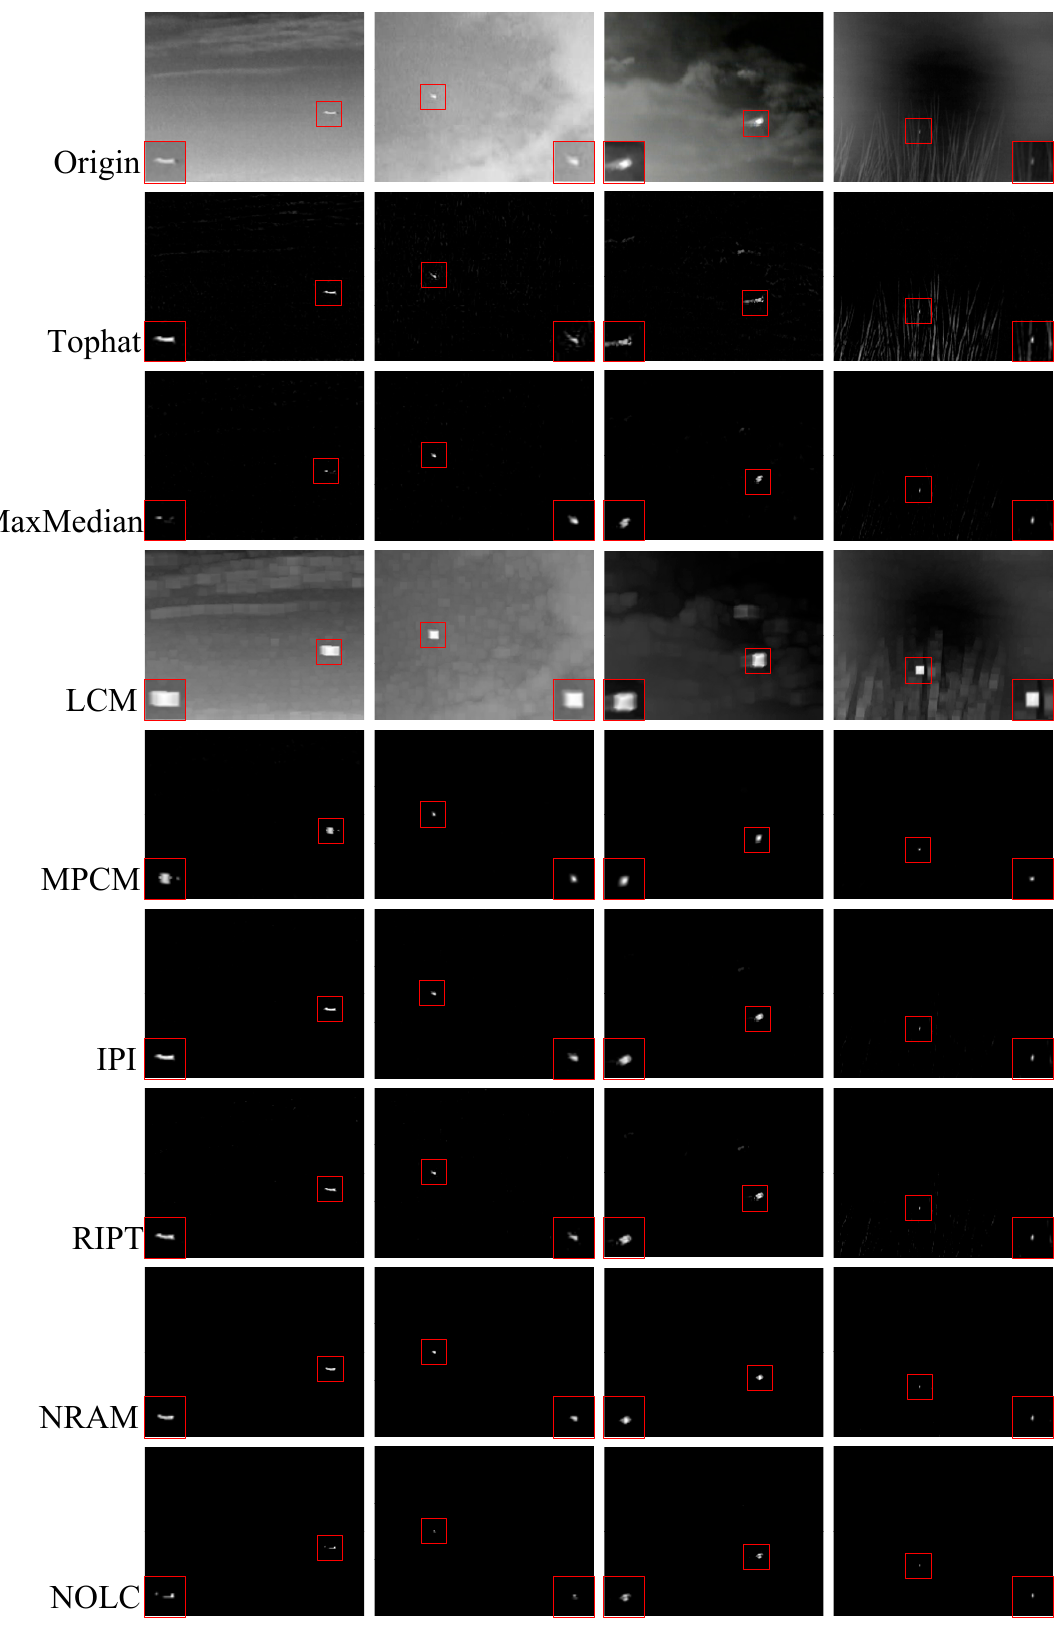
Figure 12. Performance of multiple methods.